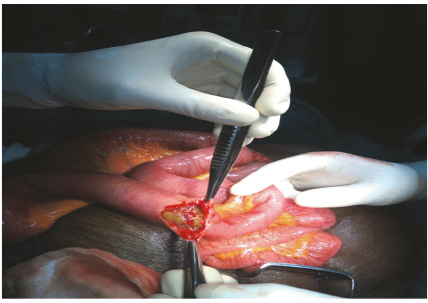
Figure 3: Obstructing distal ileal phytobezoar seen at